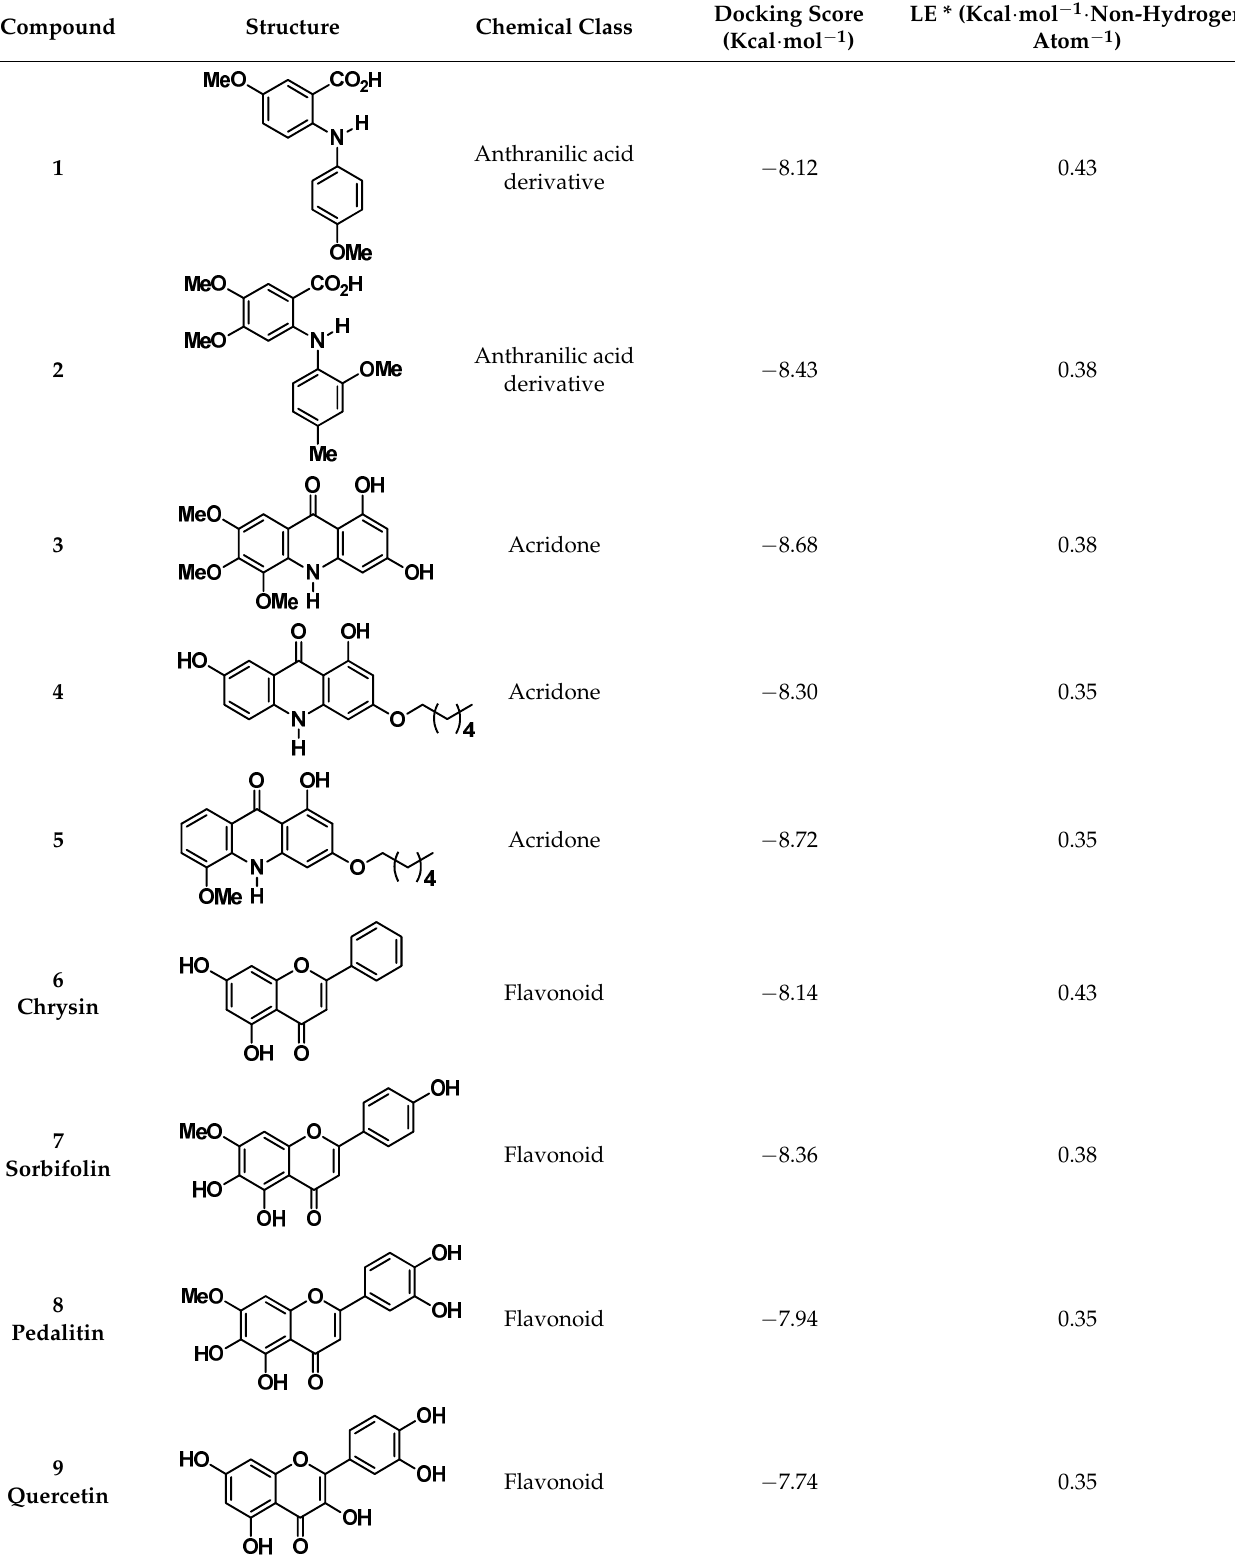
Table 1. Virtual hits prioritized based on the computational approaches.